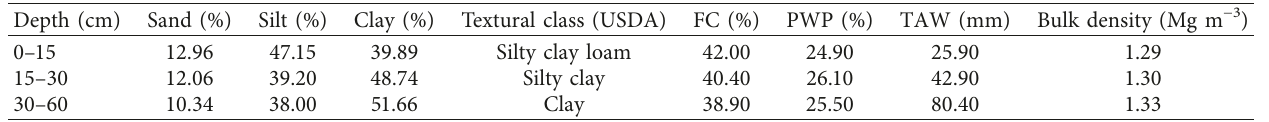
Table 1: Physical properties of the experimental soil.